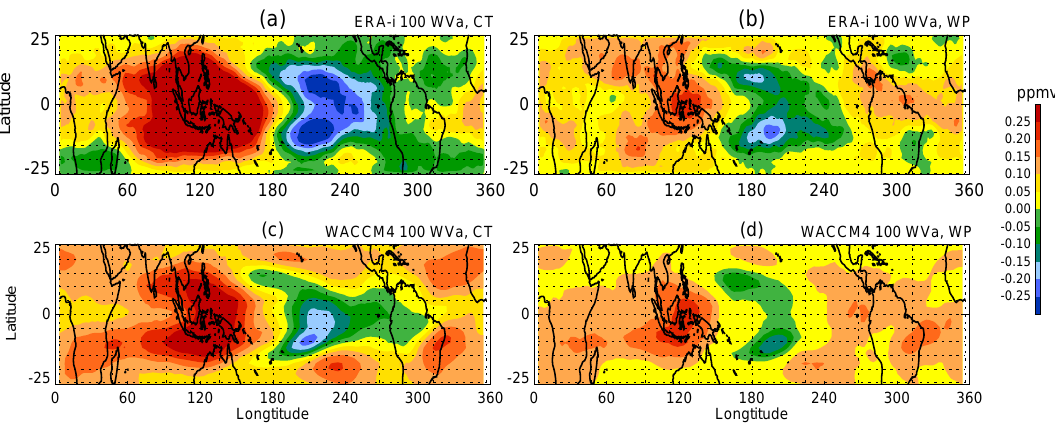
Fig. 7. Water vapor anomalies at 100 hPa based on composite ERA-Interim data, 1979–2010: (a) canonical El Ni˜no events and (b) El Ni˜no Modoki events. Water vapor anomalies at 100hPa for R2–R1 (c) and R3–R1 (d) . Contour intervals, ± 0.05ppmv water vapor.